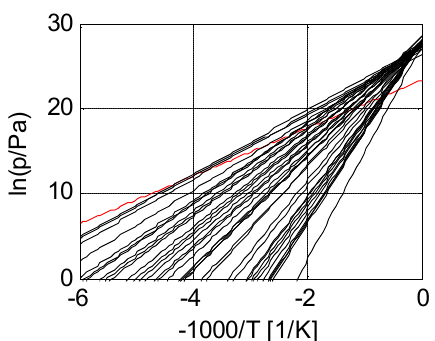
Figure 7. Vapor pressure lines of chloride ammoniates (black) and ammonia (red). This plot is an extension of an earlier plot of Neveu [11], which we extrapolated towards 1/ T = 0. Here, an approximate intersection of the pT-lines of the chloride ammoniates becomes apparent, which confirms Trouton’s rule for the collection. As anticipated, the vapor pressure line of ammonia does not intersect at 1/ T = 0 and therefore does not belong to this collection.